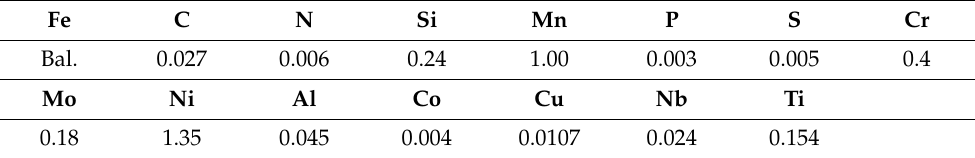
Table 1. Chemical composition of API X-120 pipeline steel (wt